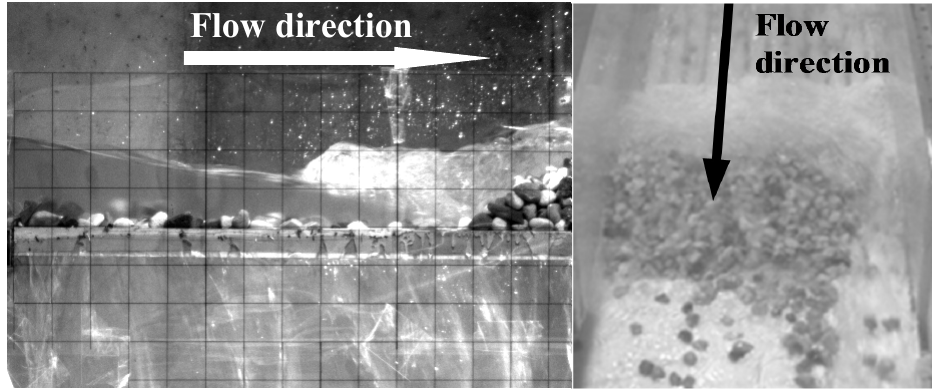
Figure 9. Deposition of gravels over the rack for the horizontal rack slope, rack C , gravel 3 and q 1 = 114.6 l/s/m